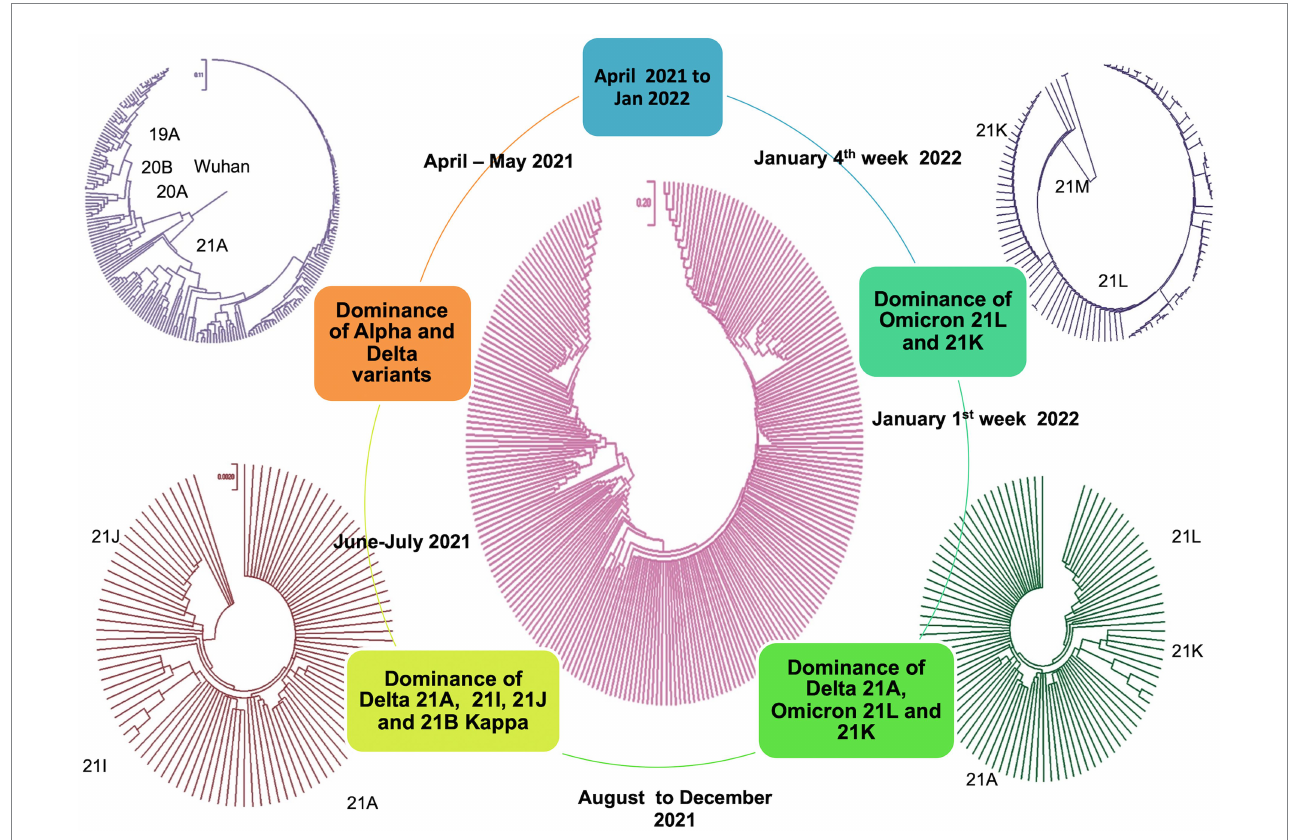
FIGURE 7 Molecular phylogenetic tree showing evolution distance profile during March 2021–January 2022 (2nd and 3rd